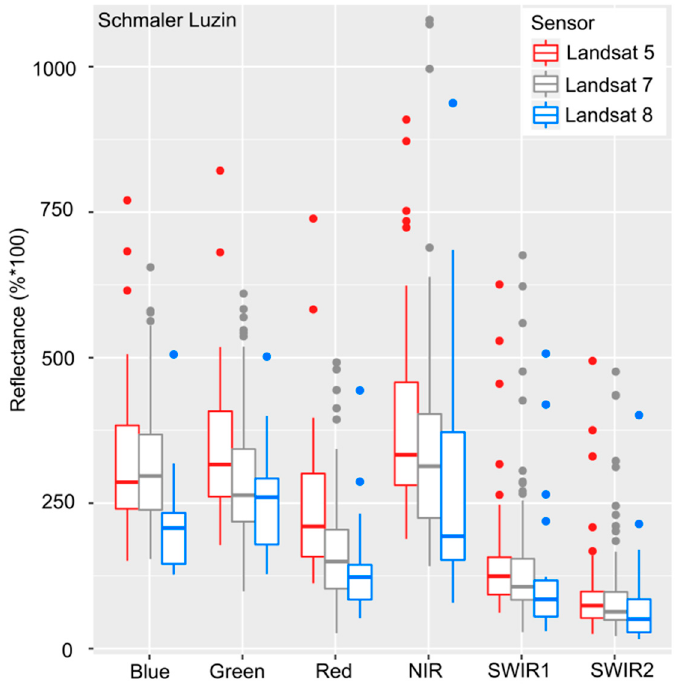
Figure 13. Variation of the mean lake spectra of lake SL between 1998 and 2015. The spectra are grouped by the Landsat satellites.